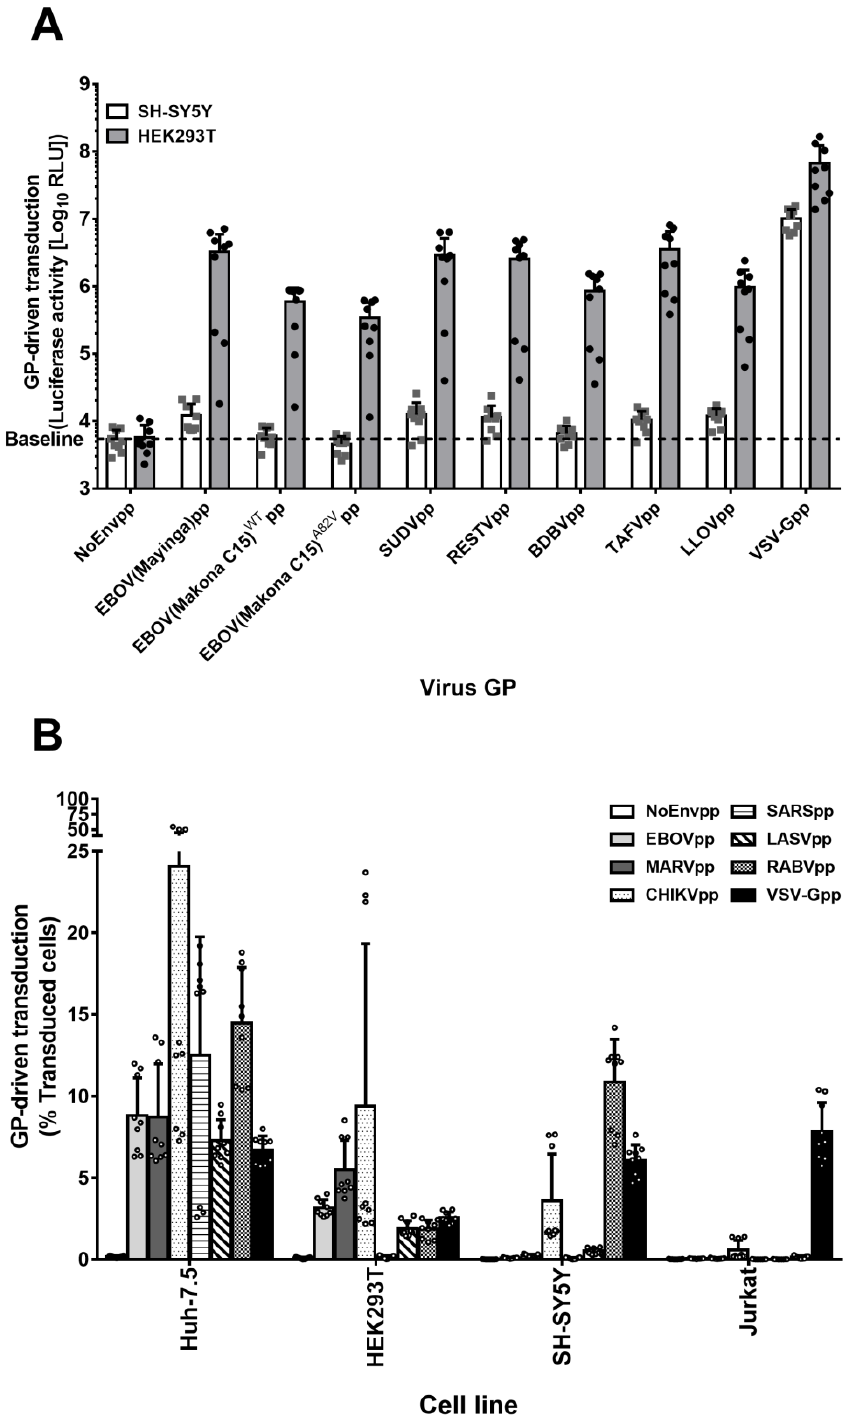
Figure 3. SH-SY5Y cells are resistant to pseudoparticles bearing either Ebolavirus species GPs but susceptible to pseudoparticles bearing glycoproteins of other virus families. ( A ) SH-SY5Y cell susceptibility to Ebolavirus species and entry-enhancing variant GPs. HEK293T and SH-SY5Y cells were transduced for 6 h with denoted pseudoparticles encoding for a firefly luciferase reporter gene. After 72 h, 100 µ L of cell lysates were measured for luciferase activity. Unspecific entry was determined by NoEnvpp RLU values. Data are the log10 RLU mean values of 3 independent transductions with 9 individual values. Error bars represent SD. ( B ) Cell–virus specificity analysis. Huh-7.5,